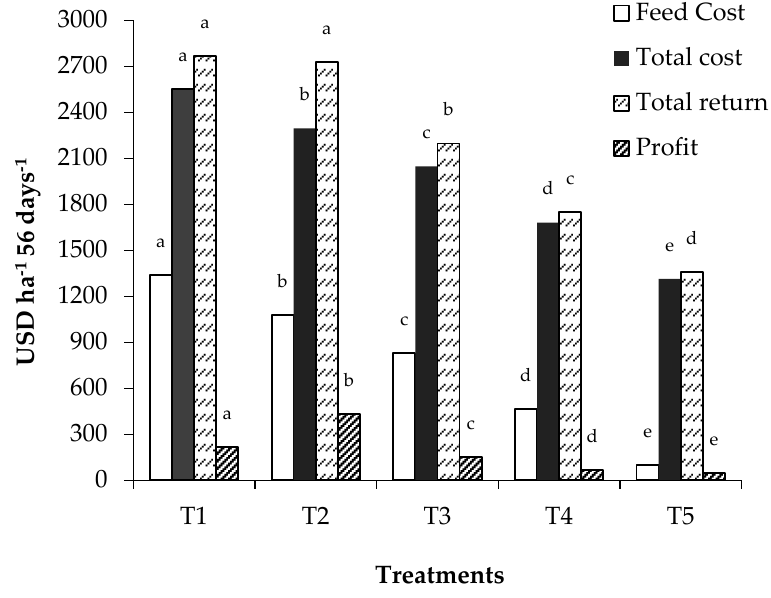
Figure 2. Cost and return (USD ha − 1 56 days − 1 ) from Thai silver barb B. gonionotus produced in five treatments fed varying proportion of A. pinnata and commercial fish feed for 56 days. Means with different superscripts (a, b, c, d and e) are significantly different ( p < 0.05).